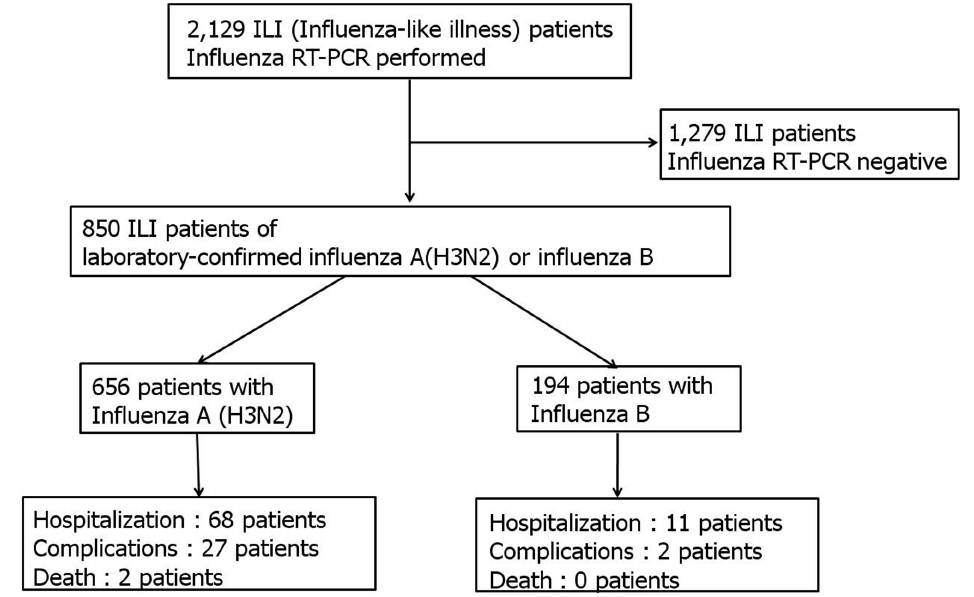
Figure 1. Subjects enrollment and analysis (total influenza-like illnesses).